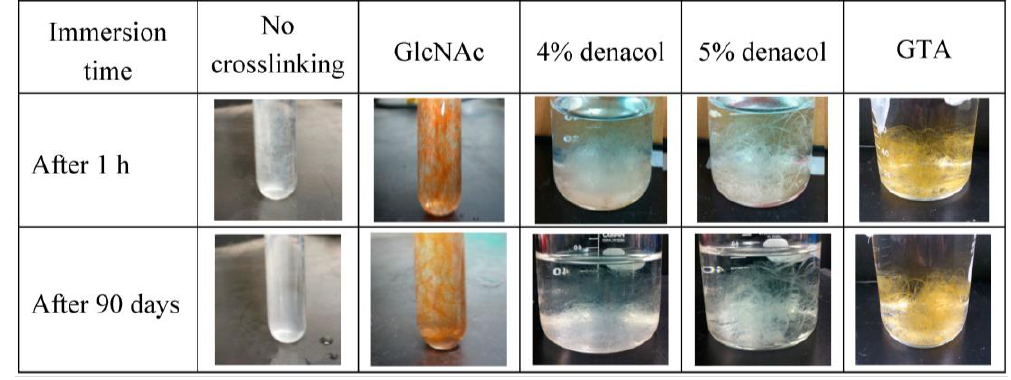
Figure 8. Water resistance of each crosslinked fiber.